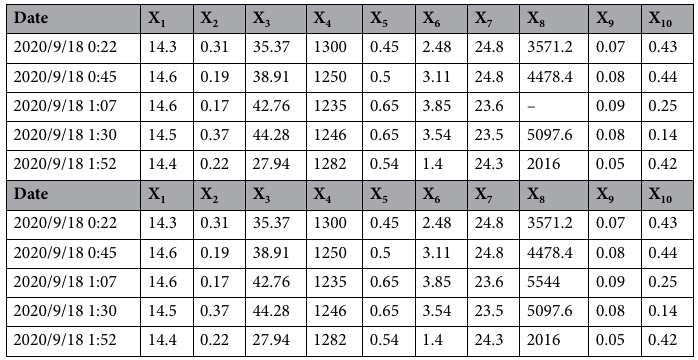
Table 3. Comparison table of missing values before and after